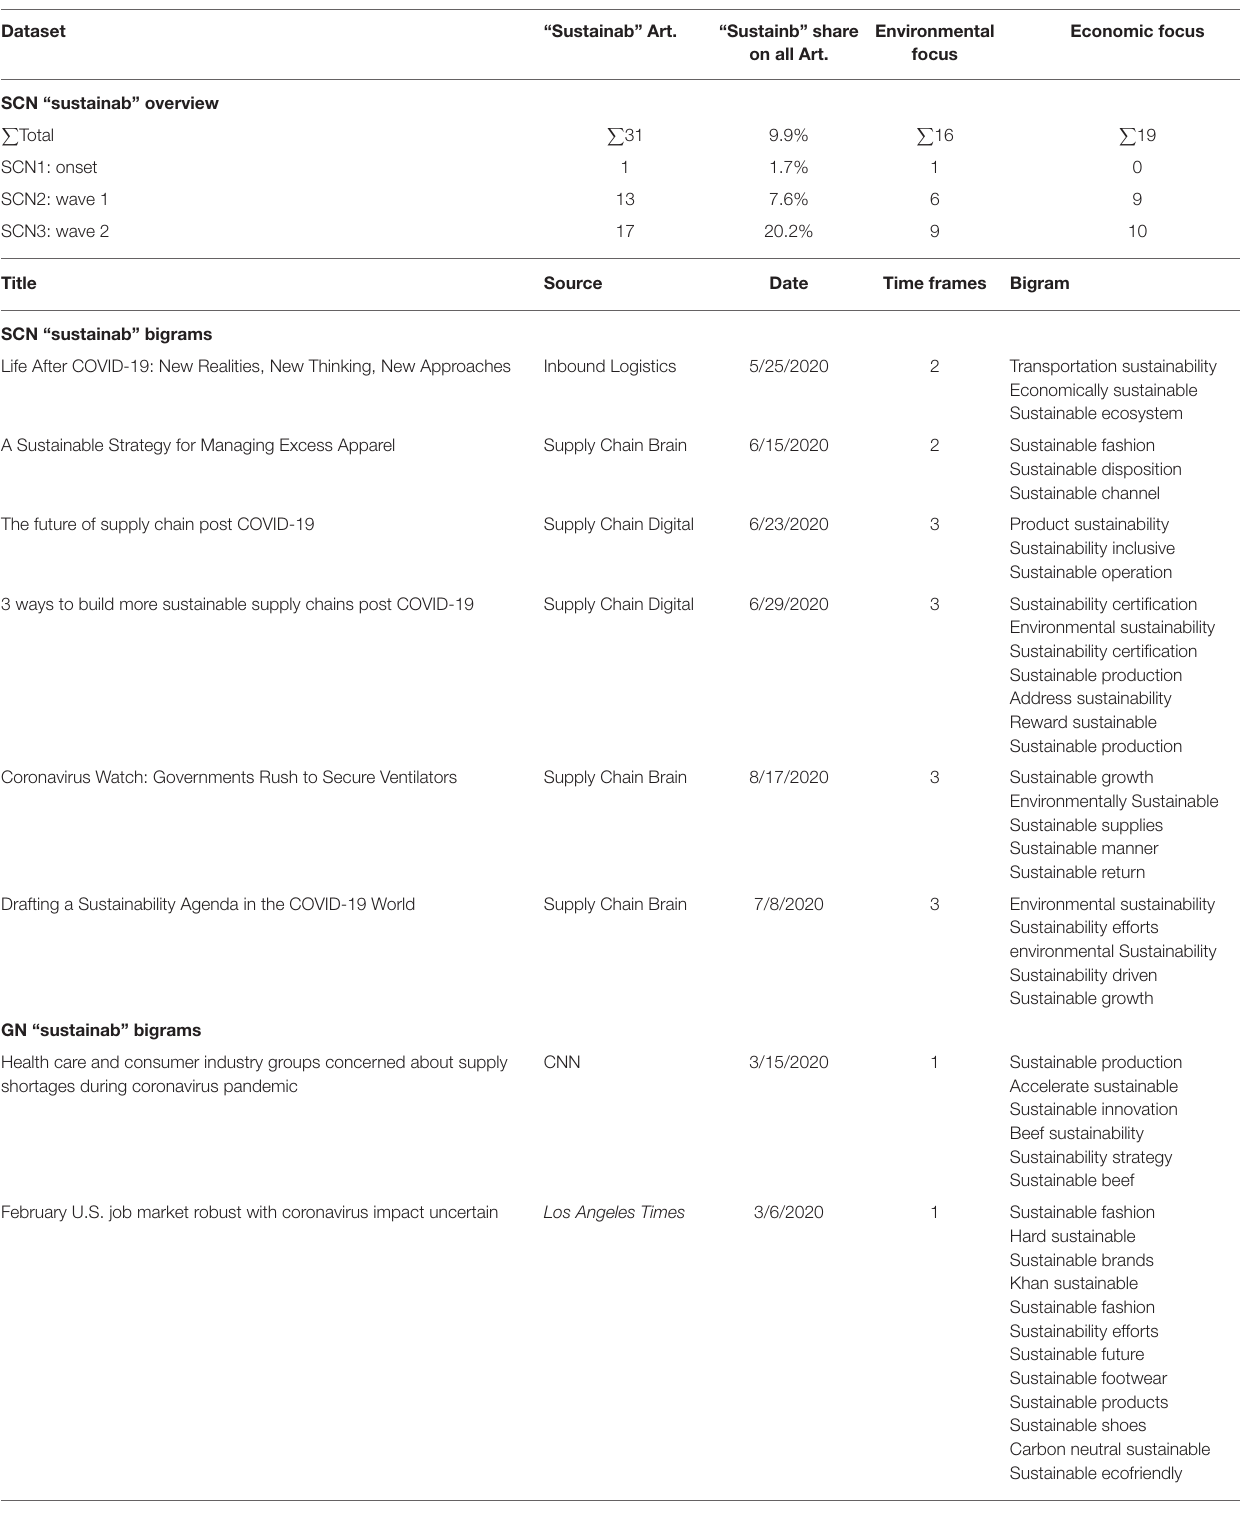
TABLE 3 | “sustainab”